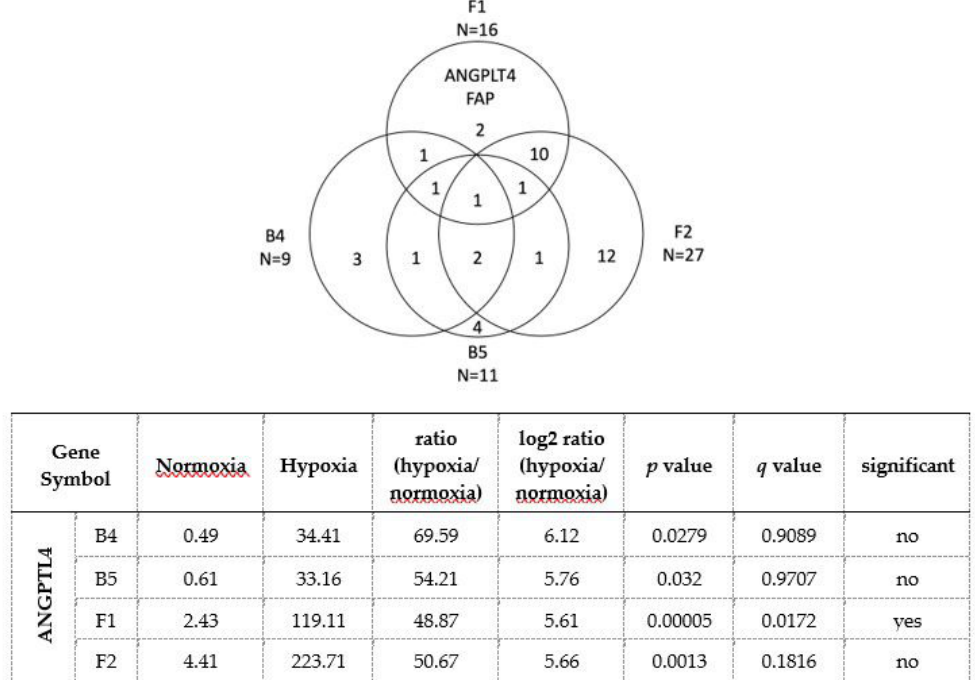
Figure 5. Gene expression profiling of F1 and F2 cybrids compared to B4 and B5 cybrids using the RNASeq technology. The Venn diagram illustrates the number of di ff erentially expressed genes (DEGs) between hypoxic-ischemic for 24 h and normoxic conditions in cybrids harboring haplogroups F1, F2, B4, and B5. The two genes specific to stroke-susceptible haplogroup F1 were ANGPLT4 and FAP. FAP: Fibroblast activation protein alpha; ANGPLT4: Angiopoietin like 4; FPKM: Fragments Per Kilobase of transcript per Million mapped reads; q -value, false discovery rate (FDR) adjusted p